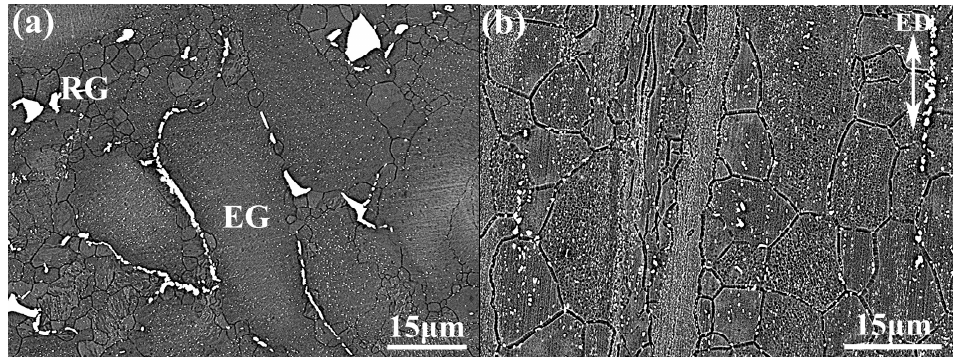
Figure 4. SEM micrograph of the Mg–Zn–Y–Nd alloy with one-pass hot extrusion: ( a ) cross-sectional microstructure showing the dual-size grain structure, ( b ) longitudinal–sectional microstructure showing the elongated grain structure (RG: recrystallized grain, EG: elongated grain).